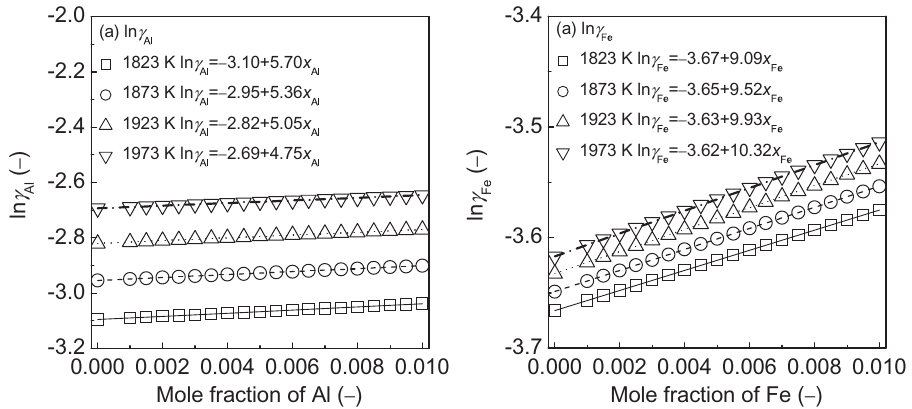
of Al (a) or relationship between mole fraction Al